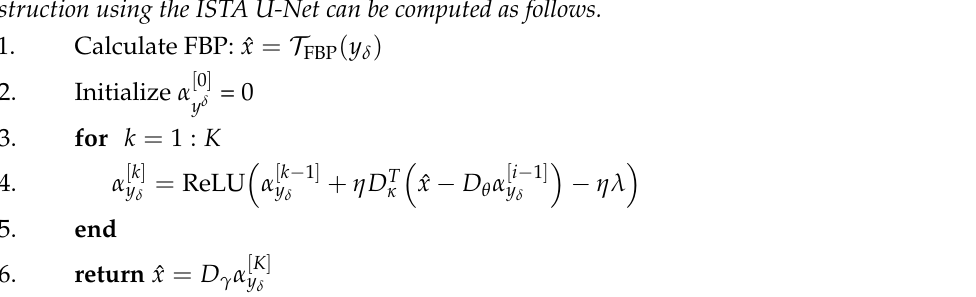
Algorithm A3 ISTA U-Net.